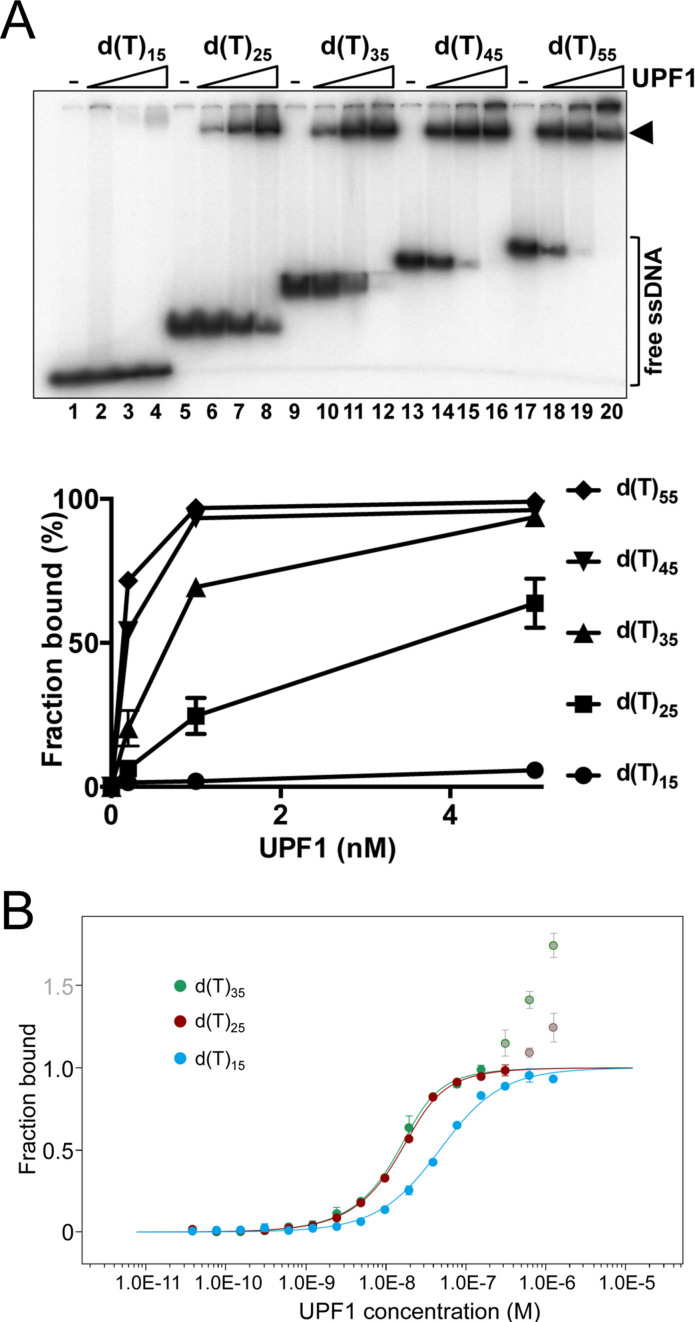
Length-dependent binding of hUPF1 to oligo d(T) substrates. (A) EMSA analysis (0.1 nM substrate, 0.2–5 nM hUPF1). hUPF1 formed a single discrete complex with increasing apparent affinity on d(T) oligonucleotide up to 35 bases in length. The bound fraction was taken as all shifted species. (B) hUPF1 (0.0381–1250 nM) binding to Alexa 647-labeled d(T)35, d(T)25 and d(T)15 substrates analysed by MST. Biphasic curves were obtained with ligands d(T)25 and d(T)35. The second event was interpreted as protein multimerization as observed in gel-shift analysis. To determine binding constants data for d(T)35 were analyzed up to 156 nM hUPF1 and for d(T)25 up to 313 nM hUPF1. Discarded values are indicated as grey circles with colored rims. Apparent Kd values of 4.05 ± 0.58 × 10−9, 5.98 ± 0.51 × 10−9 and 3.94 ± 0.36 × 10−8 M were determined for d(T)35, d(T)25 and d(T)15 respectively. EMSA and MST, n = 3 experimental repeats, mean and standard deviation.